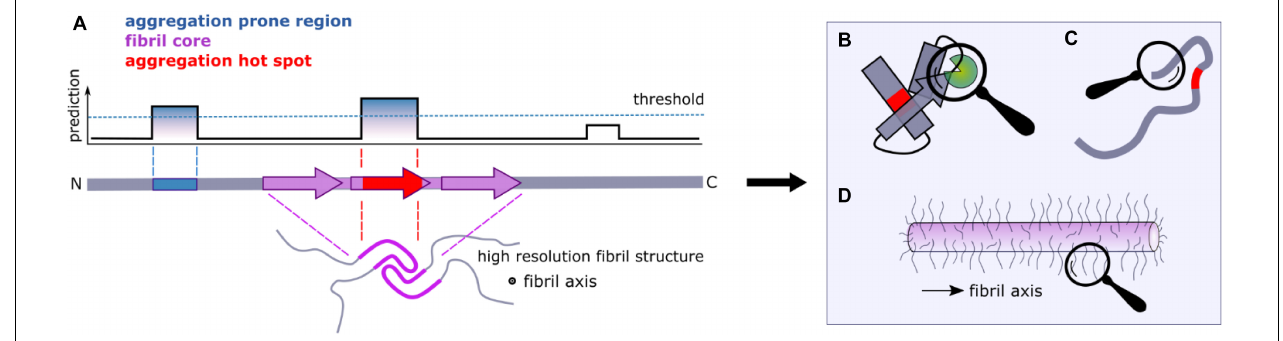
FIGURE 2 | Flanking regions and amyloid formation. (A) Computational approaches can be used to identify aggregation-prone regions (APRs) from sequence data alone (blue). Fibril cores are defined by cryoEM and ssNMR structures of amyloid fibrils and include residues that adopt a stable cross- β structure (purple). When the APRs and the fibril core overlap, we term the region as an “aggregation hotspot” (red). Large segments of a protein sequence can remain dynamically disordered in amyloid structures (lower image). (B) Interaction partners and/or (C) the formation of transient non-local intra-molecular interactions that involve regions that flank the APRs can have significant effects on the aggregation kinetics of amyloidogenic proteins, as well as on their function. (D) Dynamically disordered regions flanking the amyloid core in the fibrillar state form an amyloid “fuzzy coat” that can impart biological functions to the amyloid